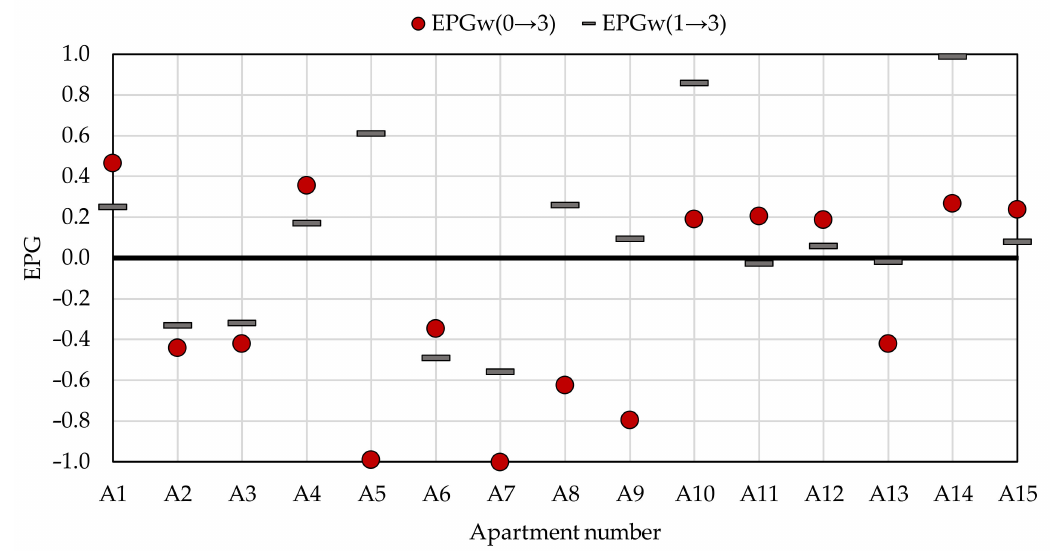
Figure 7. Energy performance gap for DHW